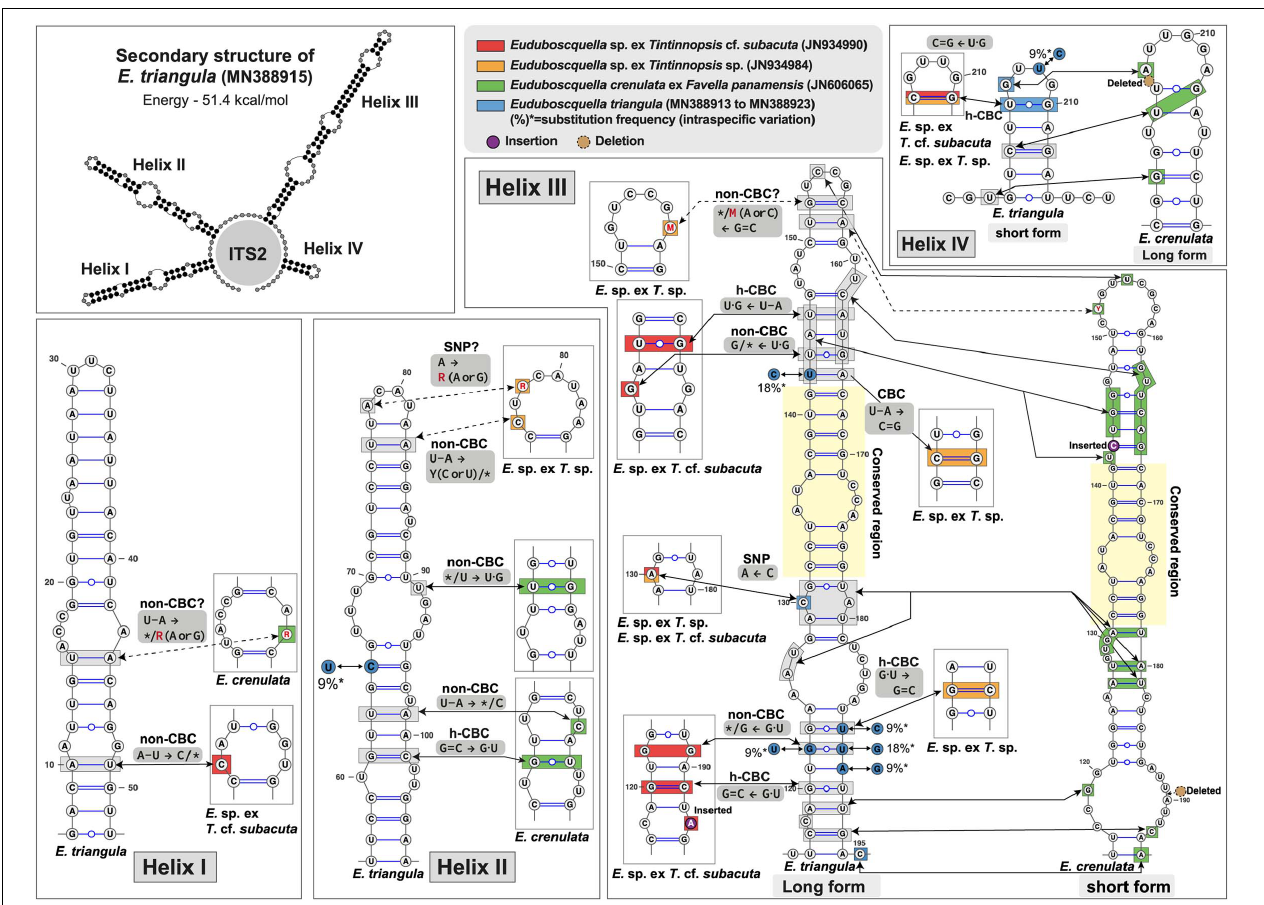
FIGURE 7 | Predicted secondary structures of the internal transcribed spacer 2 (ITS2) of Euduboscquella species. The ITS2 helices are numbered I–IV. Base changes between four Euduboscquella sequences are indicated: the red box ( E. sp. ex T. cf. subacuta ; JN934990), the orange box ( E. sp. ex T. sp.; JN934984), the green box ( E. crenulata ex F. panamensis ; JN606065), and the blue box ( E. triangula n. sp.; MN388913–MN388923). Red letters indicate ambiguous bases. Blue circles are accompanied by substitution frequency of intraspecific variation. The insertion and deletion of bases are indicated by purple and brown circles, respectively. *Means missing (unpaired)